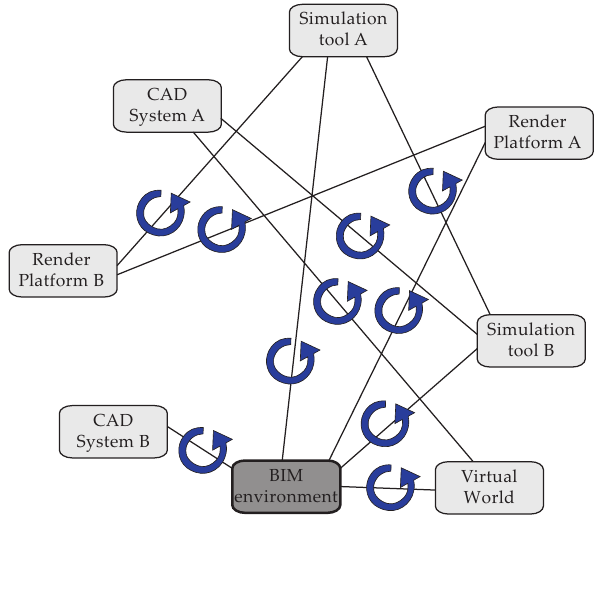
Figure 7. When relying on BIM software, “standard” file formats or any other centralised information structure, this structure is in reality just used as one of the many available information structures, with again lots of interface points (blue circular arrows) of which each represents an interpretation step between information